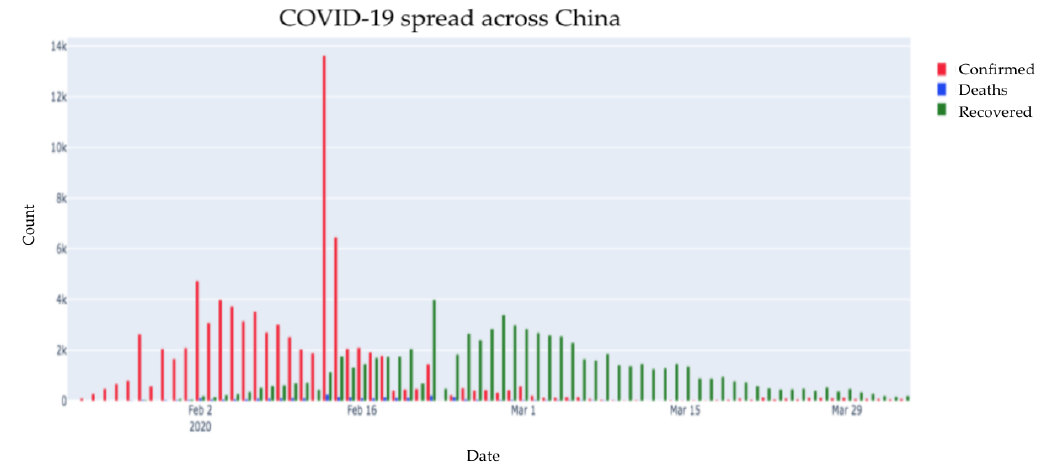
Figure 4. Distribution of all three cases for China